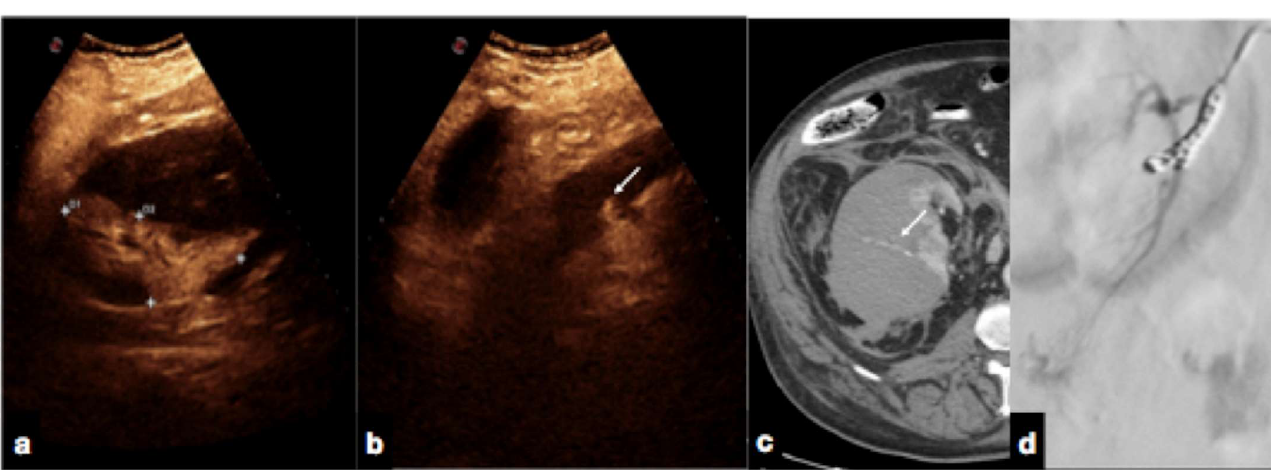
Figure 16. CEUS at day 1 ( a ) and after 2 weeks ( b ) in pancreatic trauma; note the reduction of the contusion area of pancreatic head, as well as of the peri-pancreatic fluid collection (orange line).